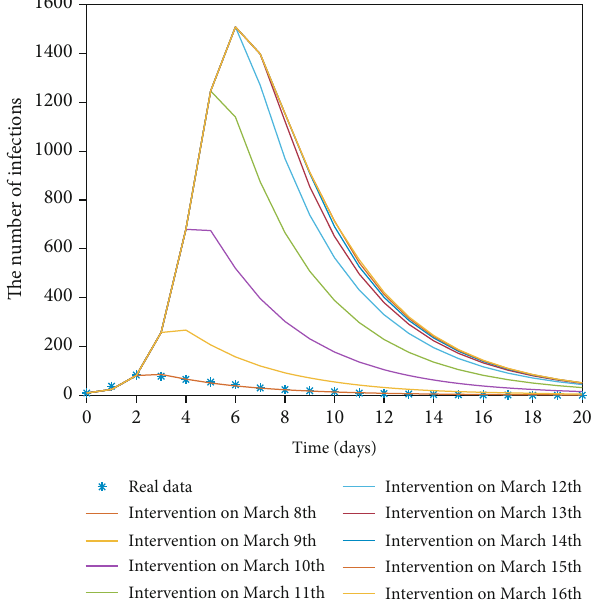
Figure 8: Changes in the number of the infections I ð t Þ of the multiterm fractional-order SEIAR model when the intervention and isolation are taken on di ff erent